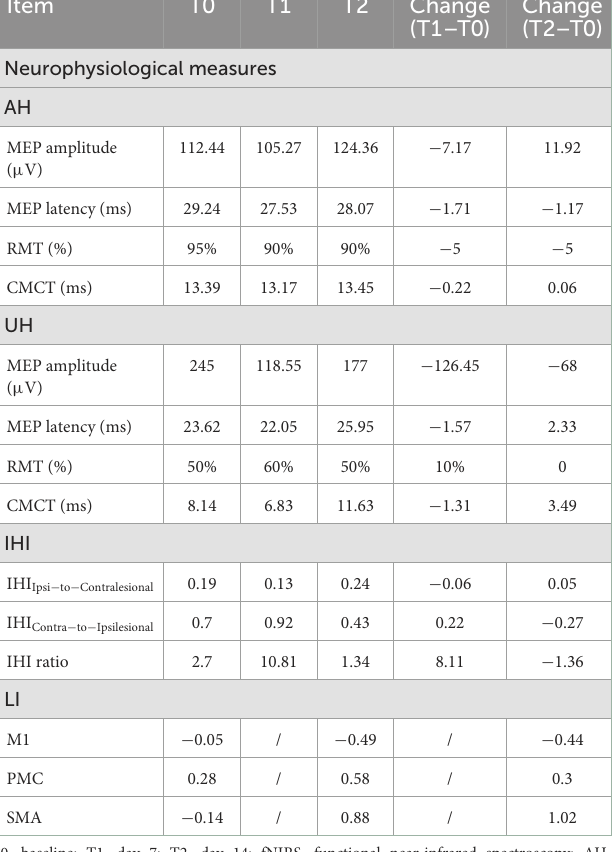
TABLE 2 Changes in neurophysiological measures and cortical asymmetry as evaluated by